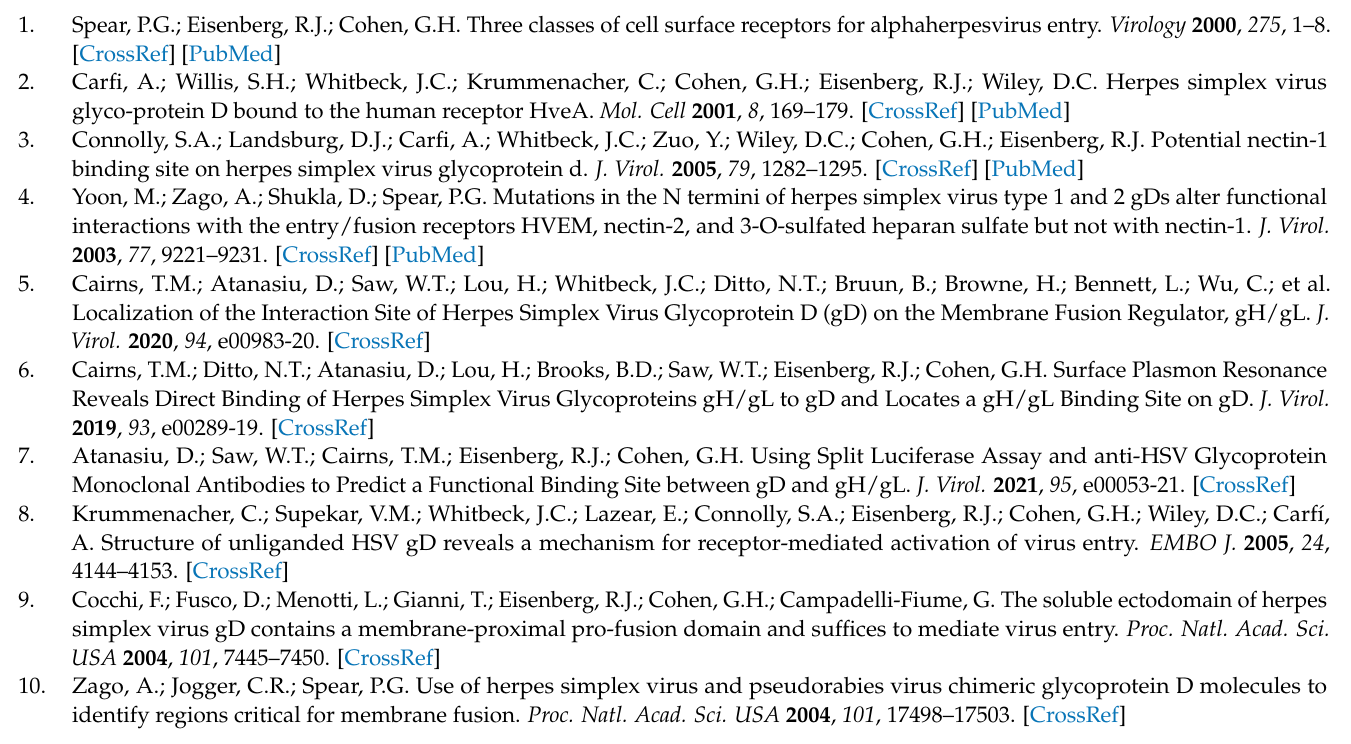
Figure S2: Characterization of soluble gD